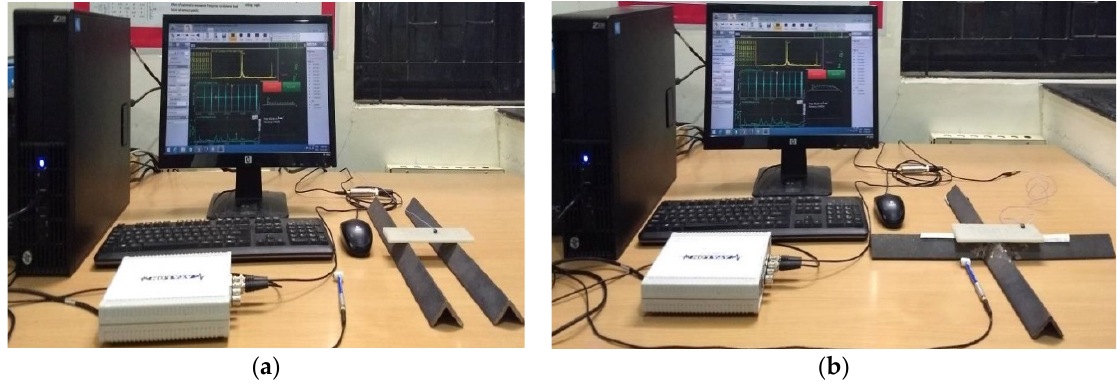
Figure 3. ( a ) Out of Plane frequency. ( b ) Torsional frequency setup.